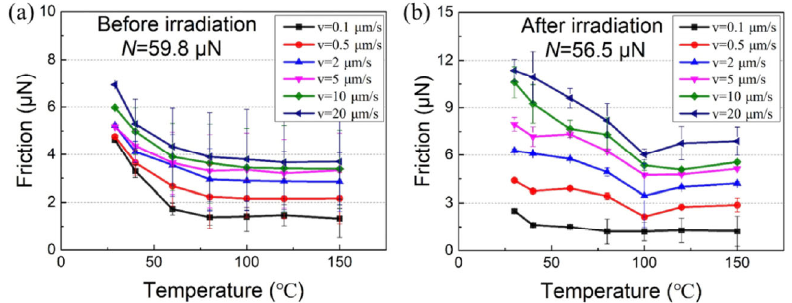
Fig. 3 Temperature dependence of friction at different velocity for mesas not exposed (a) and exposed (b) to Argon plasma irradiation. Friction decreases at low temperatures, and then levels with increasing